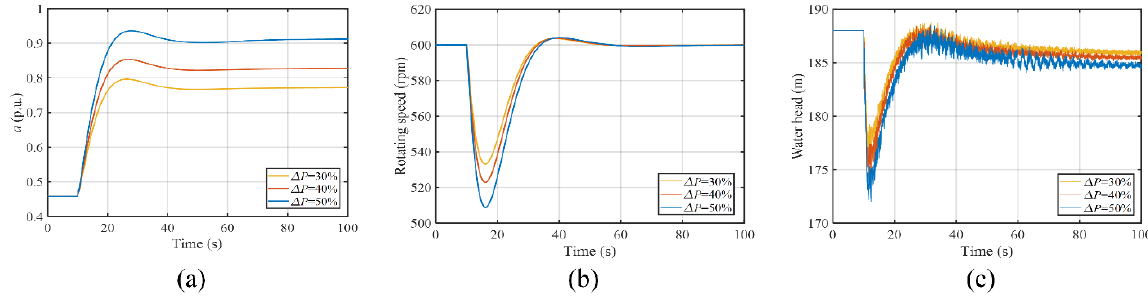
Figure 9. The operation characteristics of the hydro-turbine runner under different sudden load increasing amounts. ( a ) Guide vane opening; ( b ) rotating speed; ( c ) water head.